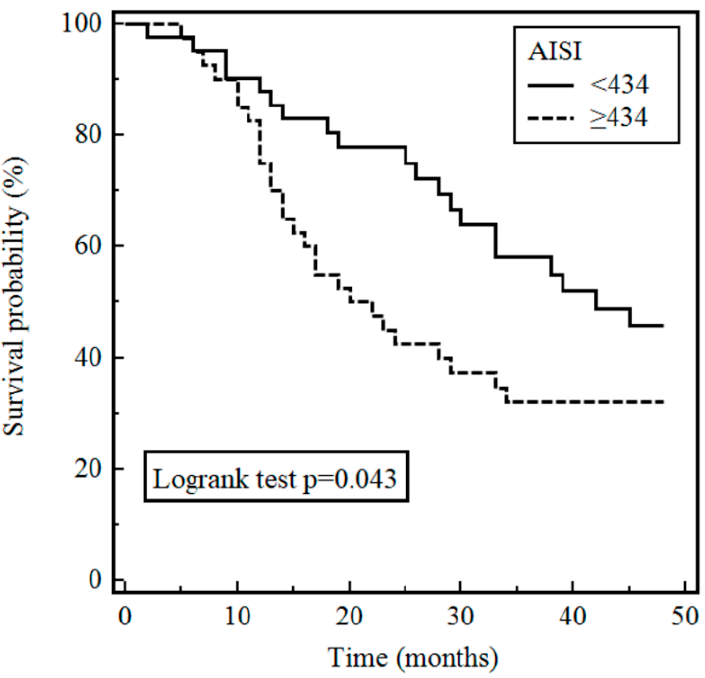
Table 4. Kaplan–Meier survival analysis of simple and combined blood cell count indexes in patients with IPF.